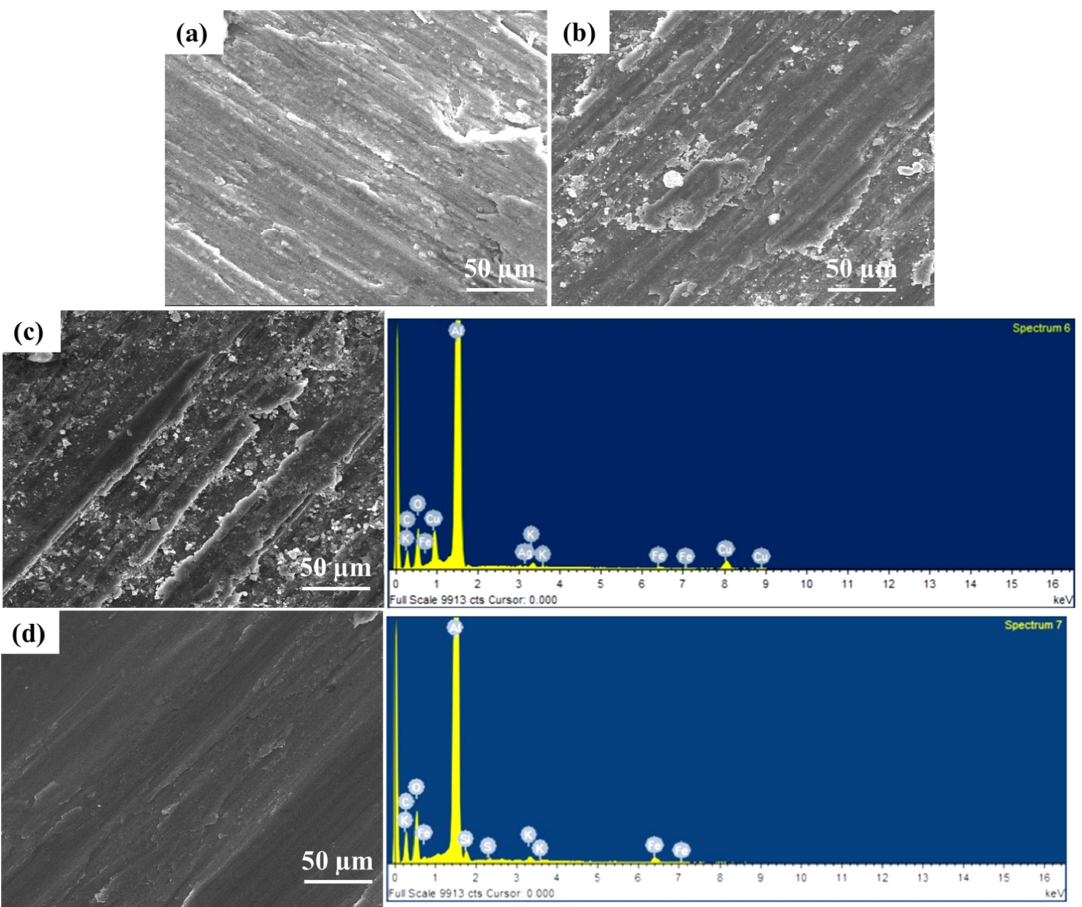
Figure 9. SEM/EDAX for AA 6061 composites with different reinforcement: ( a ) 10%SiC/3%B 4 C, ( b ) 8%SiC/5%B 4 C, ( c ) 5% SiC/8% B 4 C, ( d ) 3% SiC/10% B 4 C.